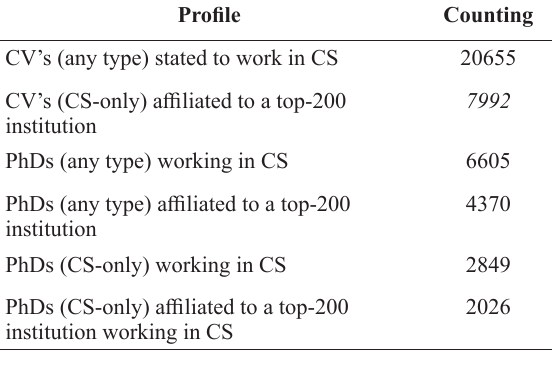
Summary of statistics about collected Curriculum Vitaes.